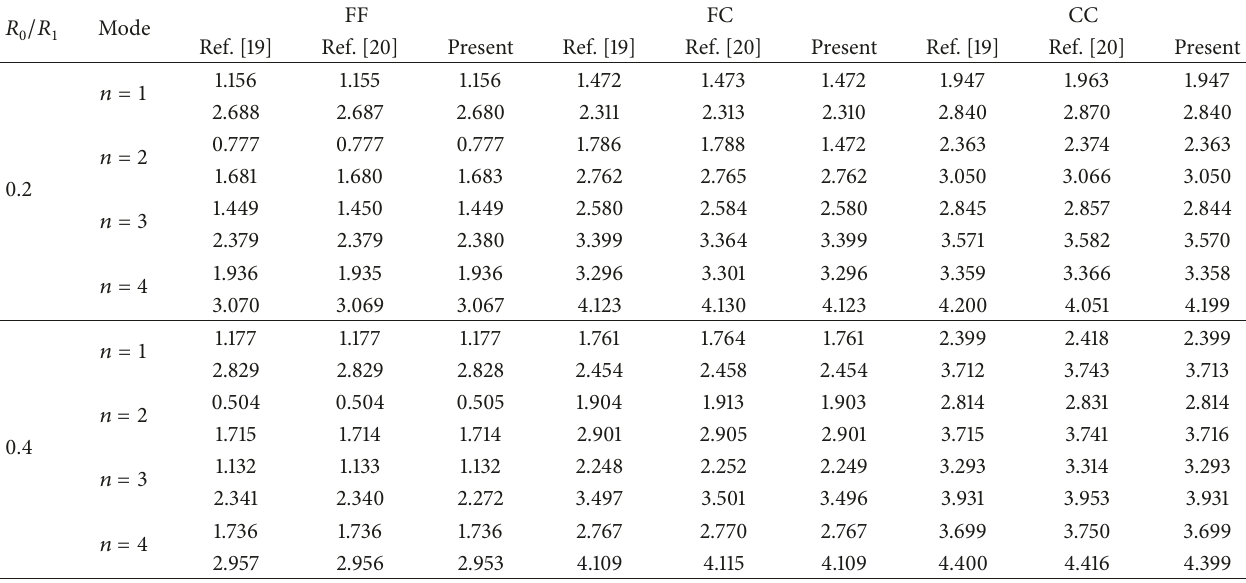
Table 3: Comparison of frequency parameters Ω = (2𝜔𝑅 1 /𝜋)√(𝜌/(𝐸(1 − ] 2 ))) for annular plates with various boundary conditions. 𝑅 /𝑅 0 1